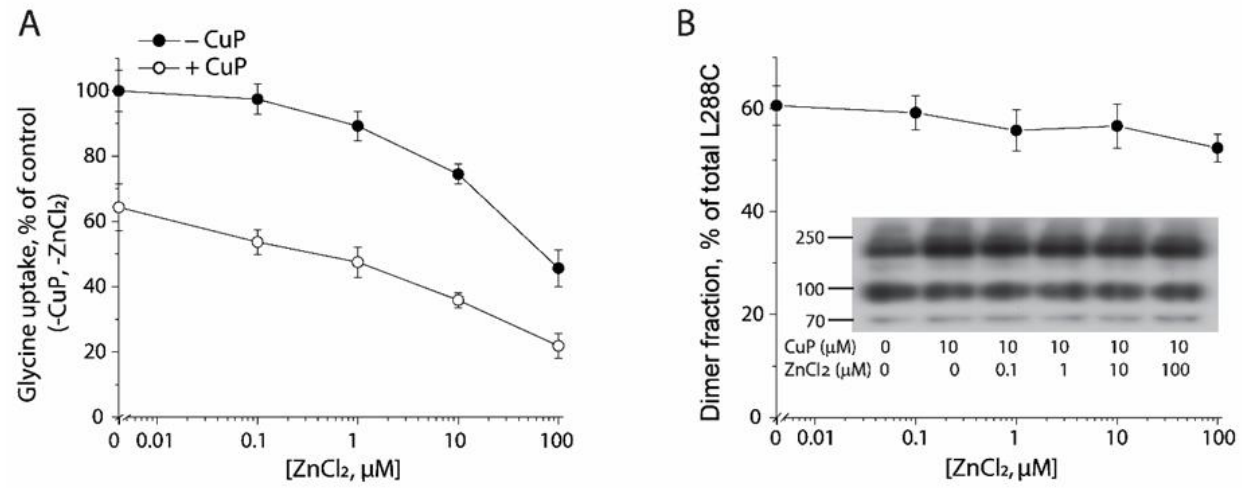
Figure 6. Influence of Zn 2+ on CuP cross-linking and transport activity of L288C. ( A ) Influence of CuP on Zn 2+ induced decrease in transport activity of L288C. HEK293 cells stably expressing L288C were treated with ZnCl 2 at indicated concentrations in the absence or presence of 10 µ M CuP at 22 ◦ C for 15 min and [ 3 H]glycine uptake was measured as described under “Materials and Methods”. The graph showed a representative experiment with triplicate measurements. The experiment was repeated twice with similar results. Glycine uptake was expressed as a percentage of glycine uptake of L288C without both CuP and ZnCl 2 treatments. ( B ) Influence of ZnCl 2 on CuP-induced cross-linking of L288C. HEK293 cells stably expressing L288C were treated with ZnCl 2 at indicated concentrations in the absence or presence of 10 µ M CuP at 22 ◦ C for 15 min. After quenching, L288C in cell lysates was detected by immunoblot analysis. A representative immunoblot was shown (inset). Dimer fraction was expressed as a percentage of fully glycosylated dimers in total L288C. All results are presented as mean ± SEM averaged from three independent